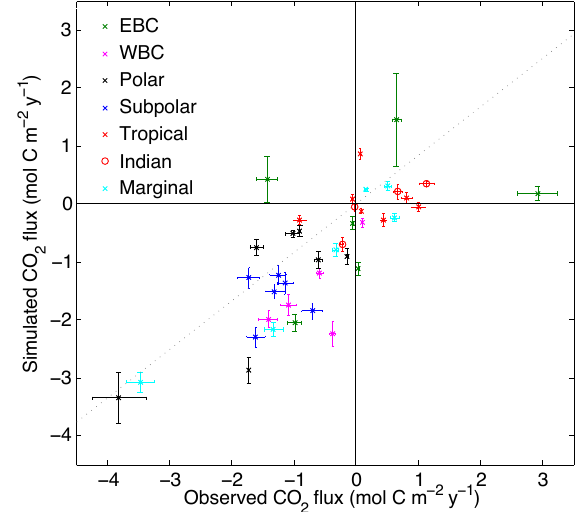
Figure 6. Simulated vs. observed MARCATS sea-to-air flux of total carbon in (a) molCm − 2 yr − 1 and (b) TgCyr − 1 . Vertical error bars show the standard deviation from the 1993–2012 interannual vari- ability for model results and the horizontal bars correspond to the 1990–2011 variability from computational methods used in LA14 for observation-based estimates. Here, regression line (grey dotted) have y intercepts forced to 0. All MARCATS regions have been used except the Black Sea, the Persian Gulf (no data estimate), and the Sea of Okhotsk (see text).